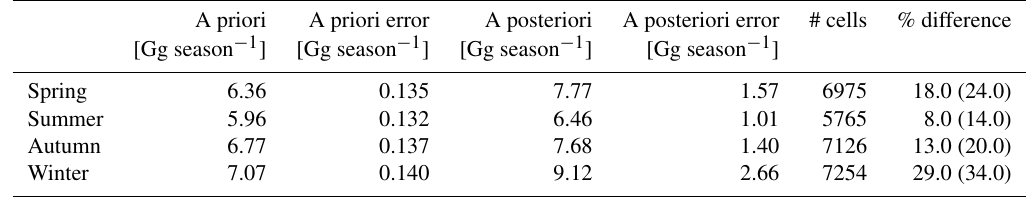
Table 2. Details of the existing emission databases used for comparative purposes. Database Years Spatial resolution Temporal Main reference Publicly available from: